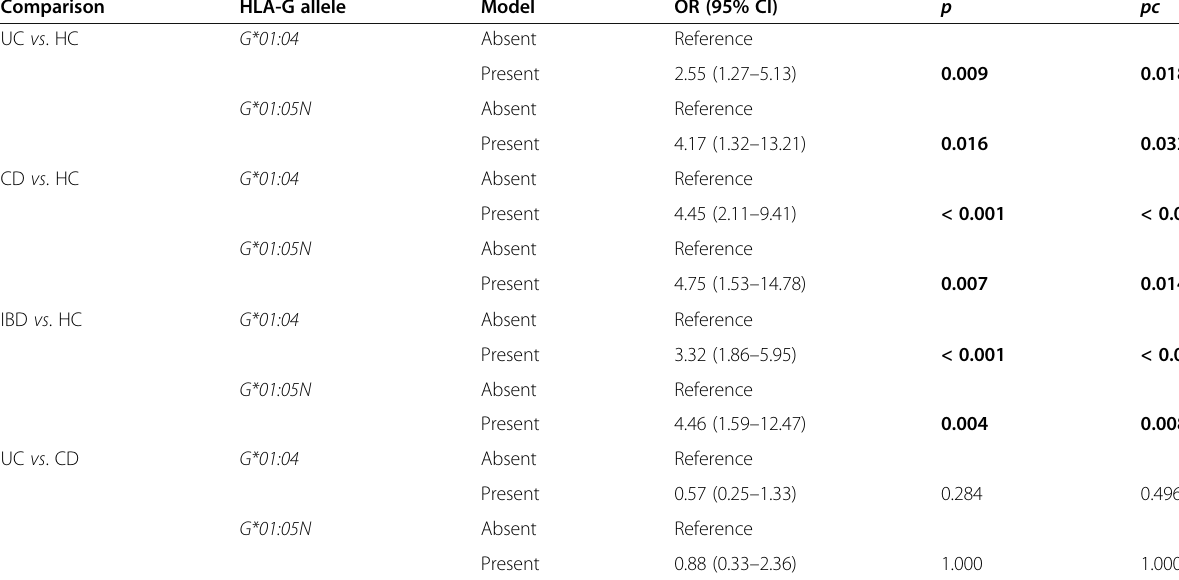
Table 4 Logistic regression analysis of HLA-G*01:04 and HLA-G*01:05N alleles in inflammatory bowel disease patients (ulcerative colitis and Crohn ’ s disease) Comparison HLA-G allele